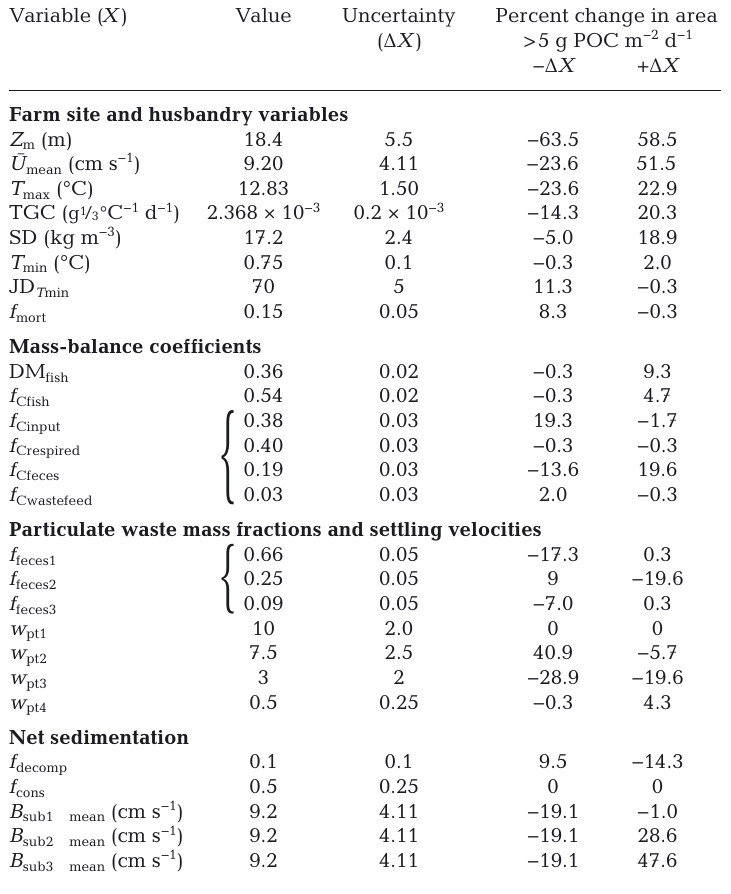
Table 3. Sensitivity of model output to changes in input variables for Farm A shown in Table 1. Percent change in contour areas is relative to baseline values for maximum total waste flux >5 g particulate organic carbon (POC) m −2 d